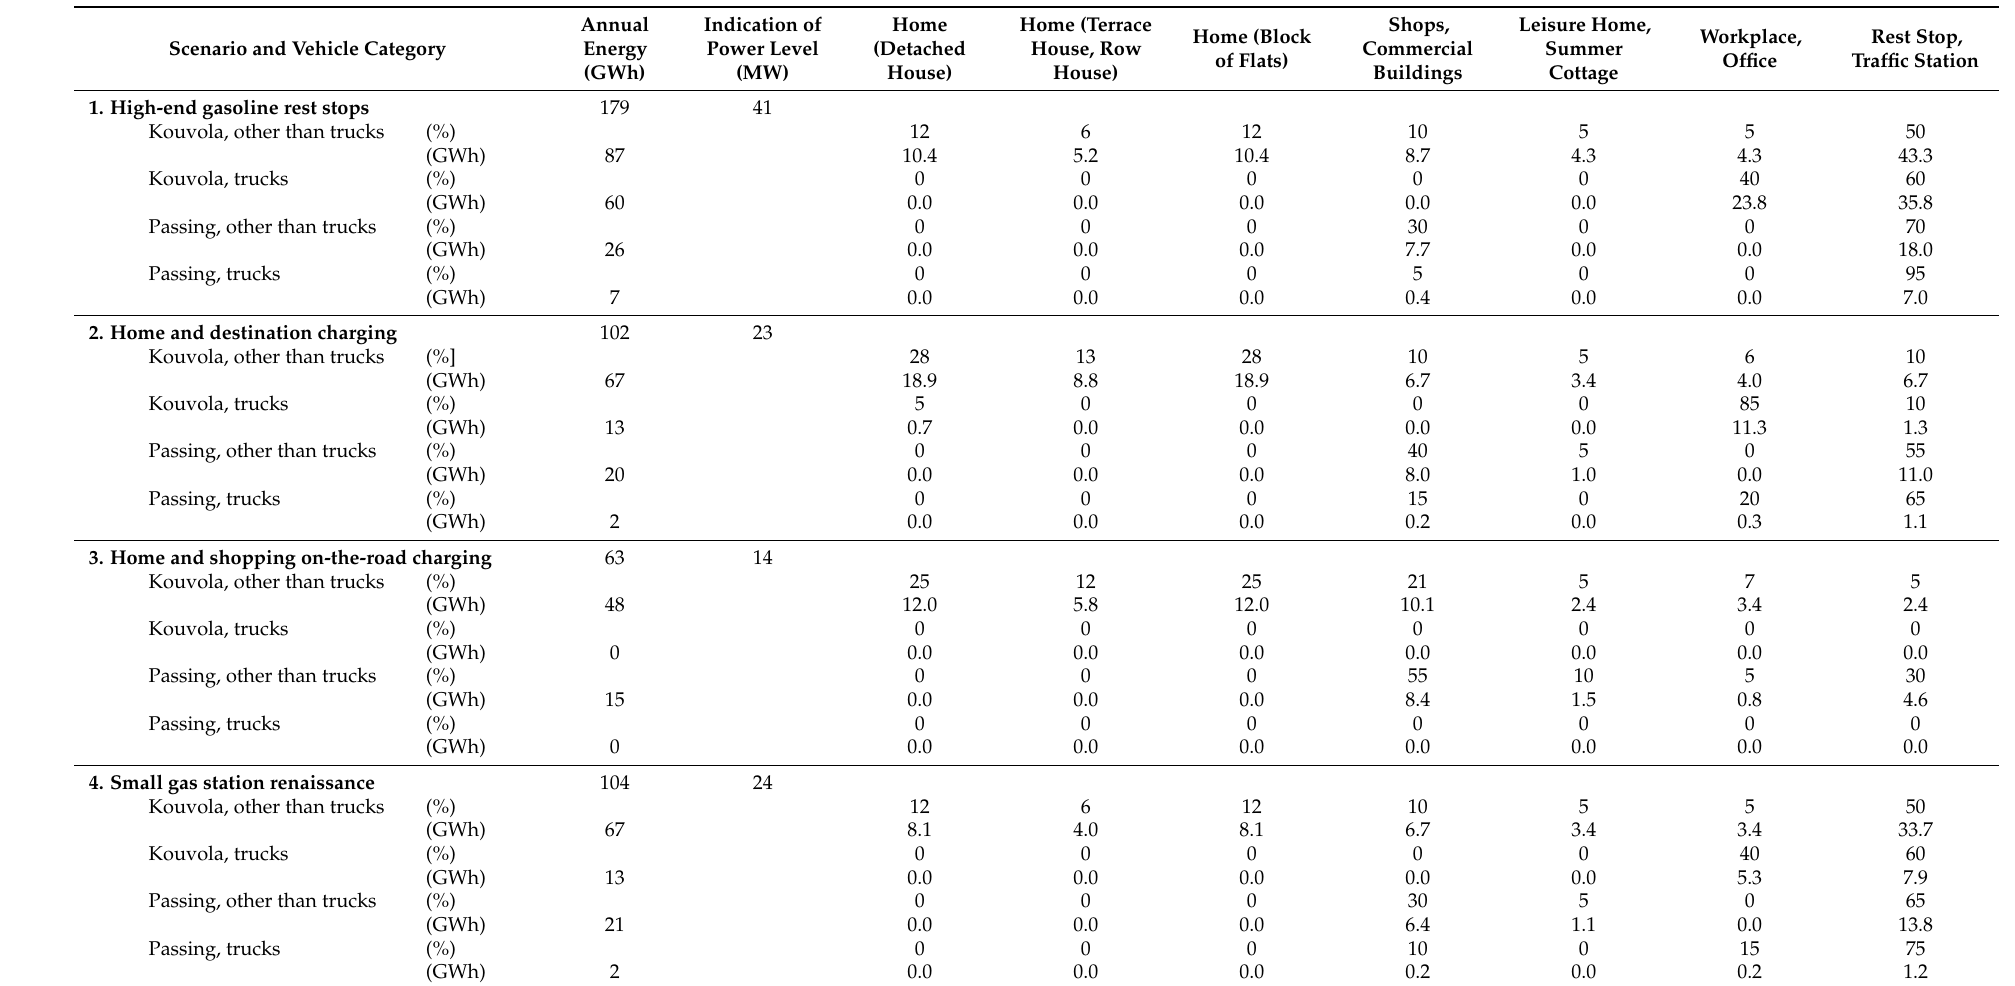
Table 4. Additional energy required by different user categories in the four